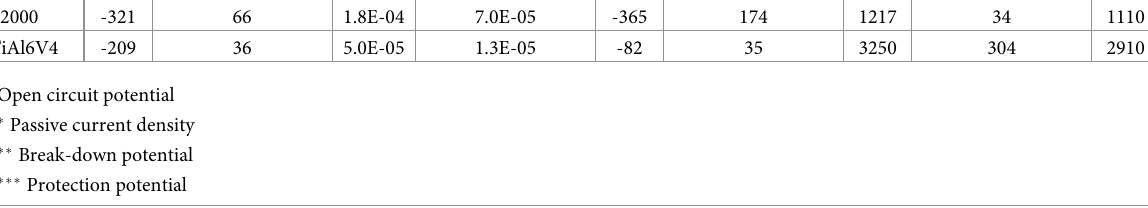
S1 Dataset. Supporting information containing the dataset used for the figures in the man- uscript.